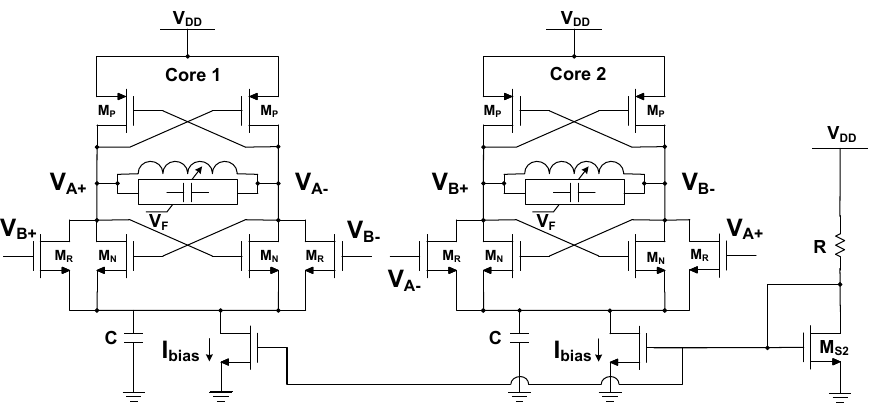
Figure 1. A schematic representation of the parallel coupled quadrature LC-tank VCO